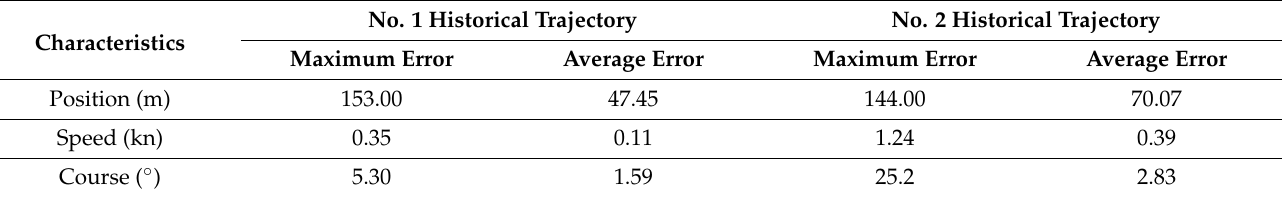
Table 8. The prediction results of test trajectories based on GRU.